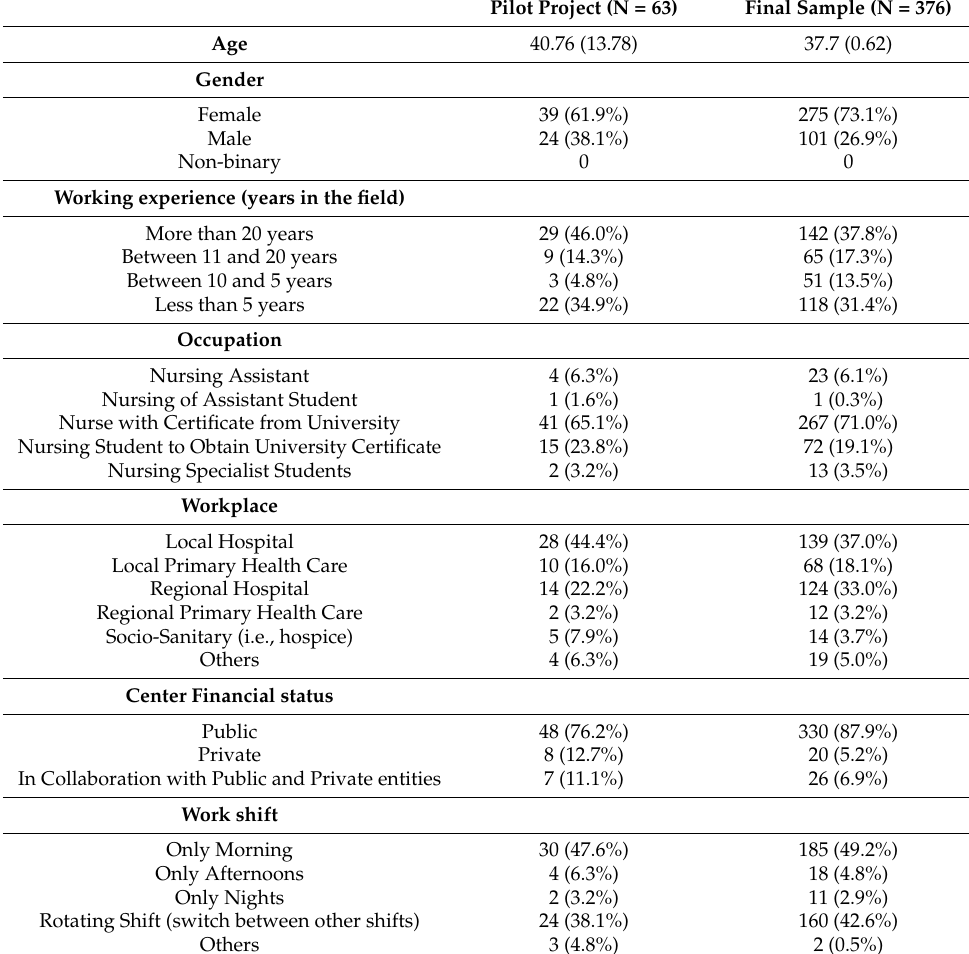
Table 1. Sociodemographic characteristics of the pilot project and final